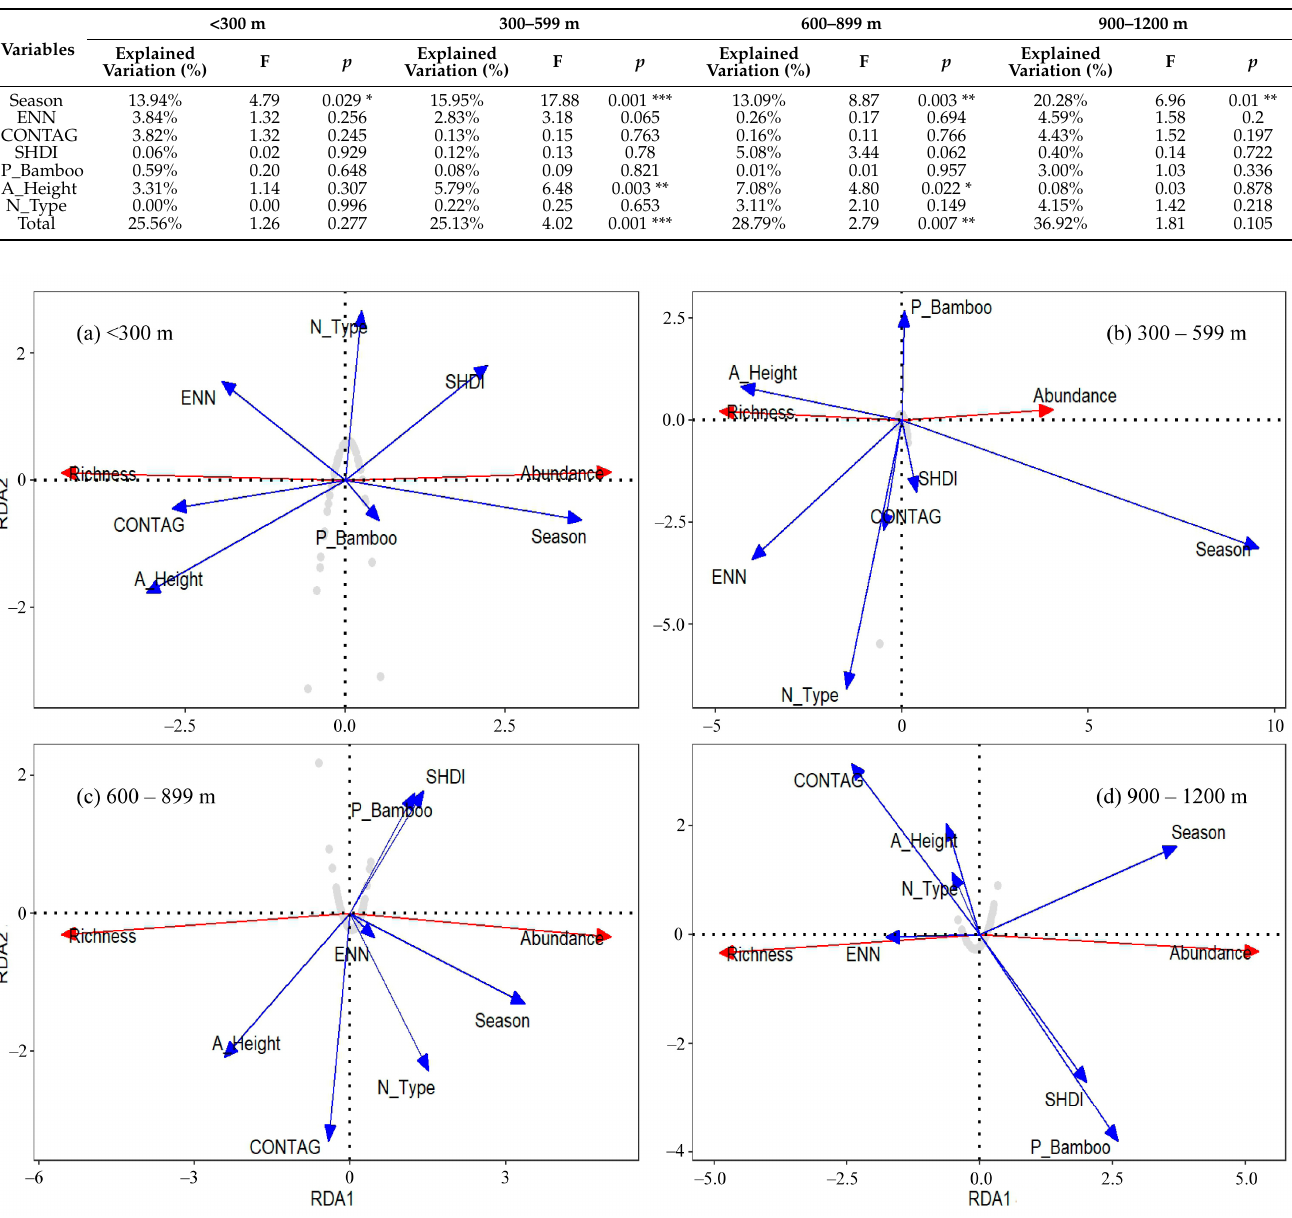
Table 5. Results of redundancy analysis (RDA). Explained variation (%): the proportion of variation that is explained by each measure. F: F statistics. P: p -value of F statistics. * p < 0.05; ** p < 0.01; *** p < 0.001. SHDI is Shannon–Wiener landscape diversity index; A_Height is the average canopy height; P_Bamboo is percentage of bamboo; ED is edge density index; ENN is Euclidean nearest-